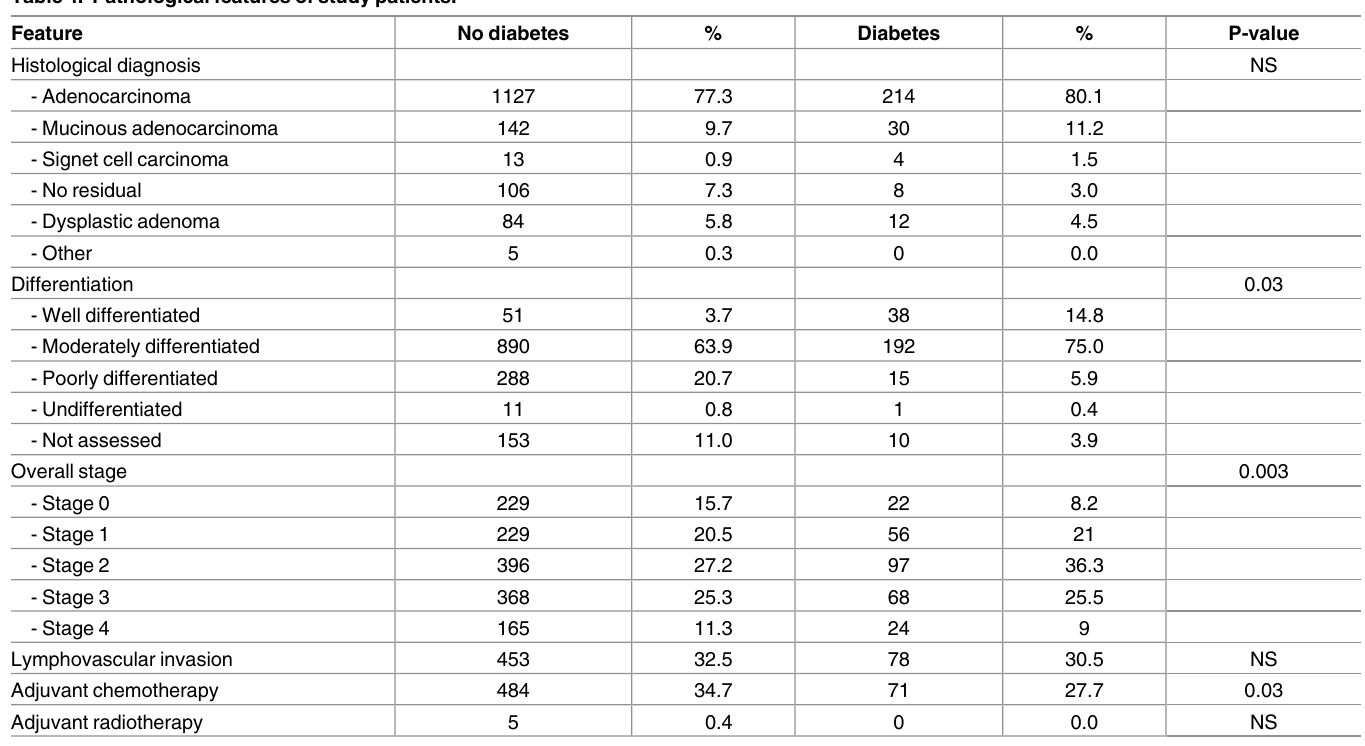
Table 4. Pathological featuresof study patients.